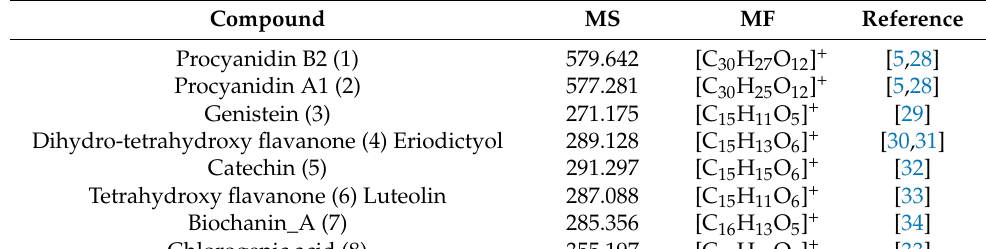
Table 2. Identified metabolites from the F. sycomorus methanol extract.